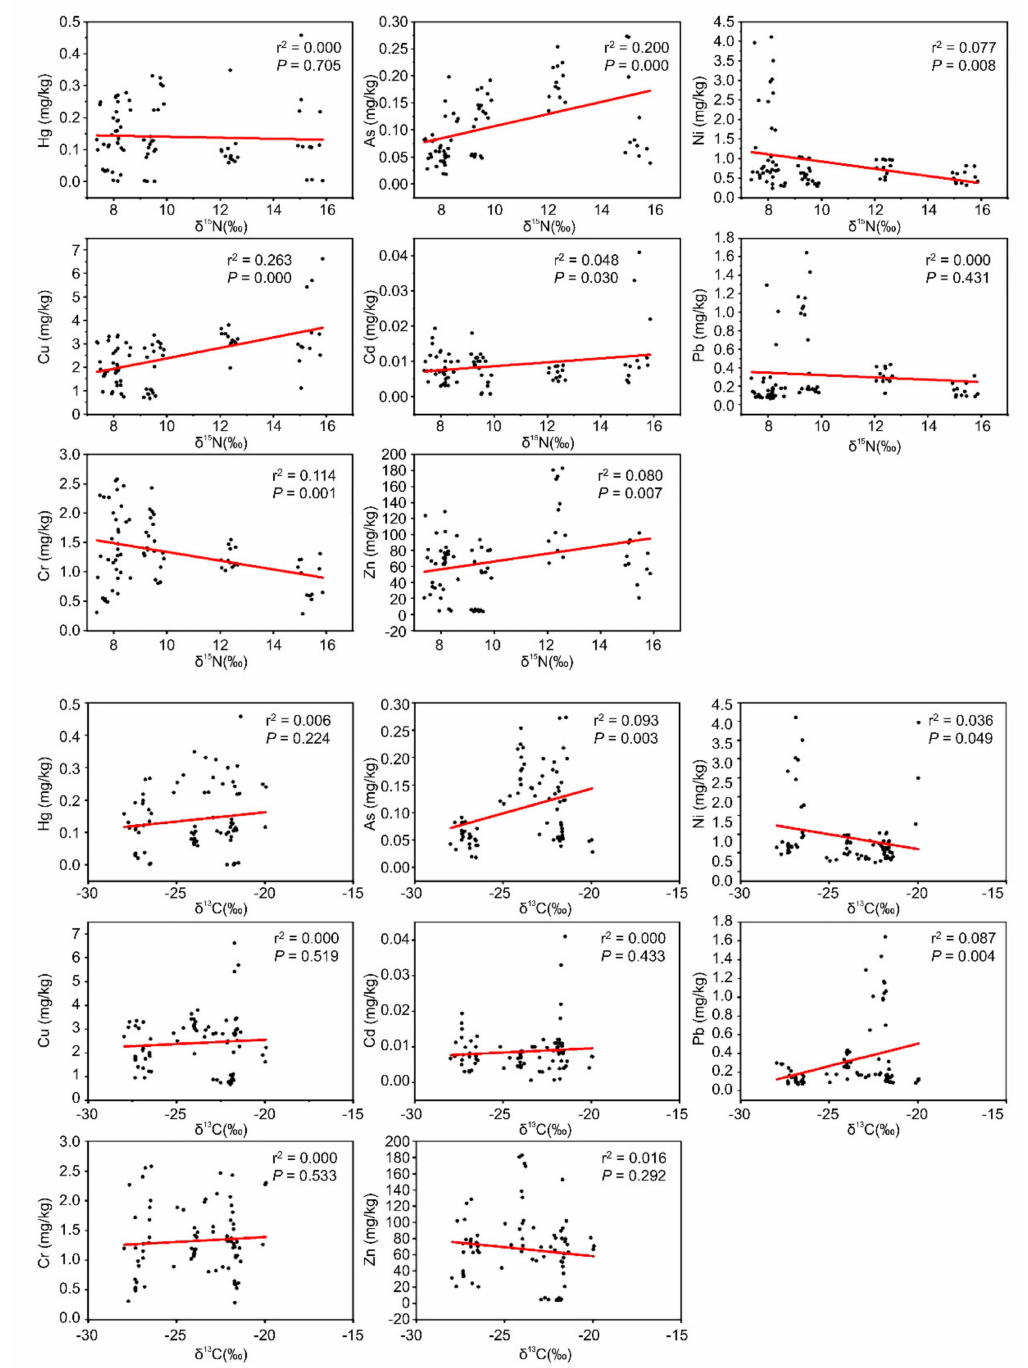
Figure 5. Regression analysis of trace metals and carbon-nitrogen isotopes in